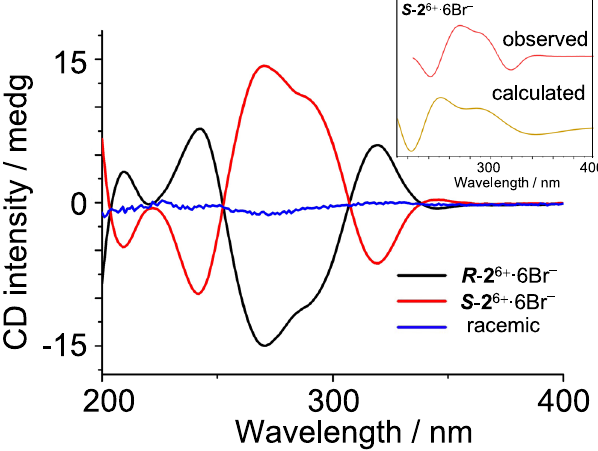
Fig. 4 CD spectra of the product (0.04 mM) S -2 6 + ·6Br – (red trace), R -2 6 + ·6Br – (black trace), and their racemic mixture (blue trace) recorded in water. The racemic cage mixture was self-assembled by condensing a racemic CHDA and the tetraaldehyde 1 2 + ·2Br – in water. Insert: the CD spectra of S - 2 6 + ·6Br – based on experiment (red trace), and theoretical calculated structure (yellow trace) which was obtained based on the optimized structure of the knot P - ᾹᾹ - S - 2 6 + shown in Fig. 5. P - ᾹᾹ - S - 2 6 + was considered as the most thermodynamically favored isomer among the four possible conformational